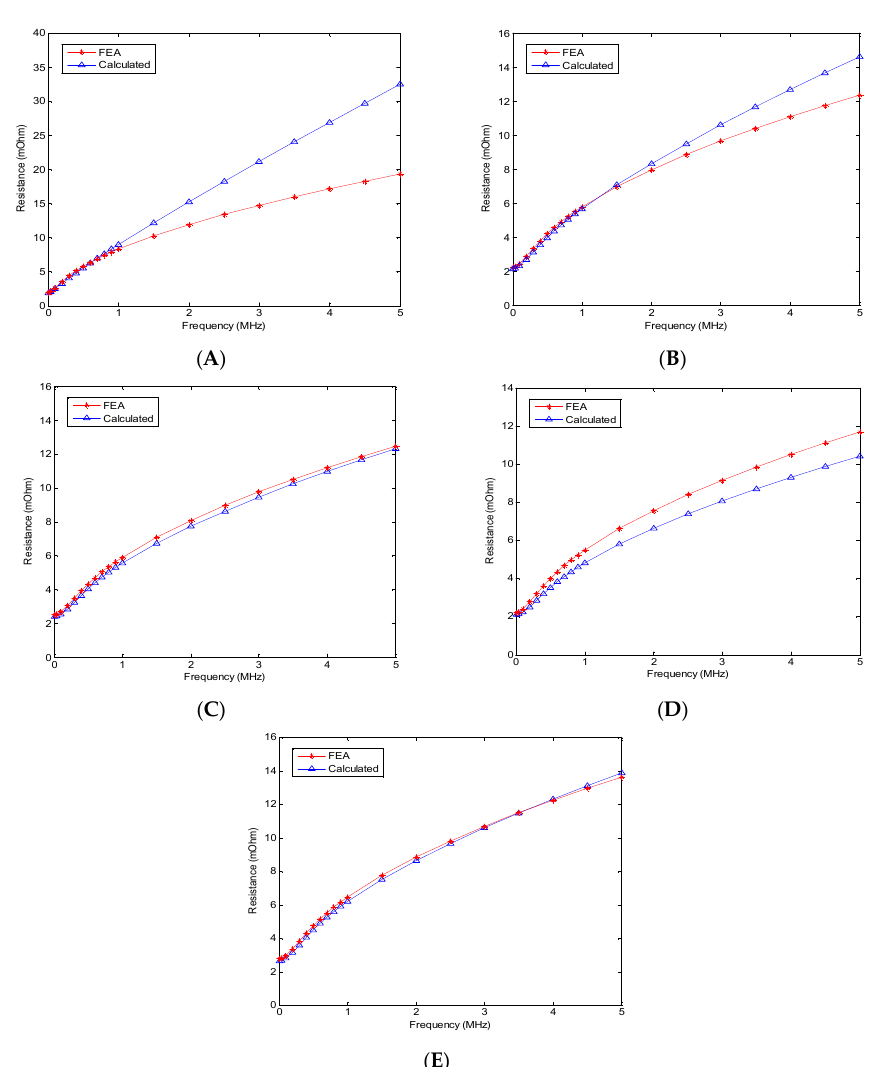
Figure 6. Equivalent resistance vs. frequency for the cases ( A – E ) described in Table 1.